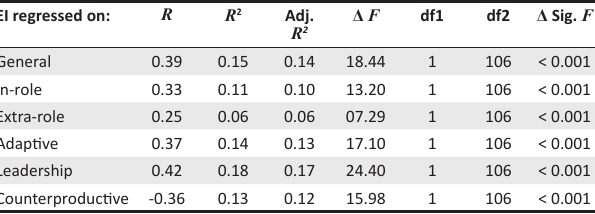
TABLE 3: Bifactor statistical indices for EQ-i 2.0 subscale factors. Factors and